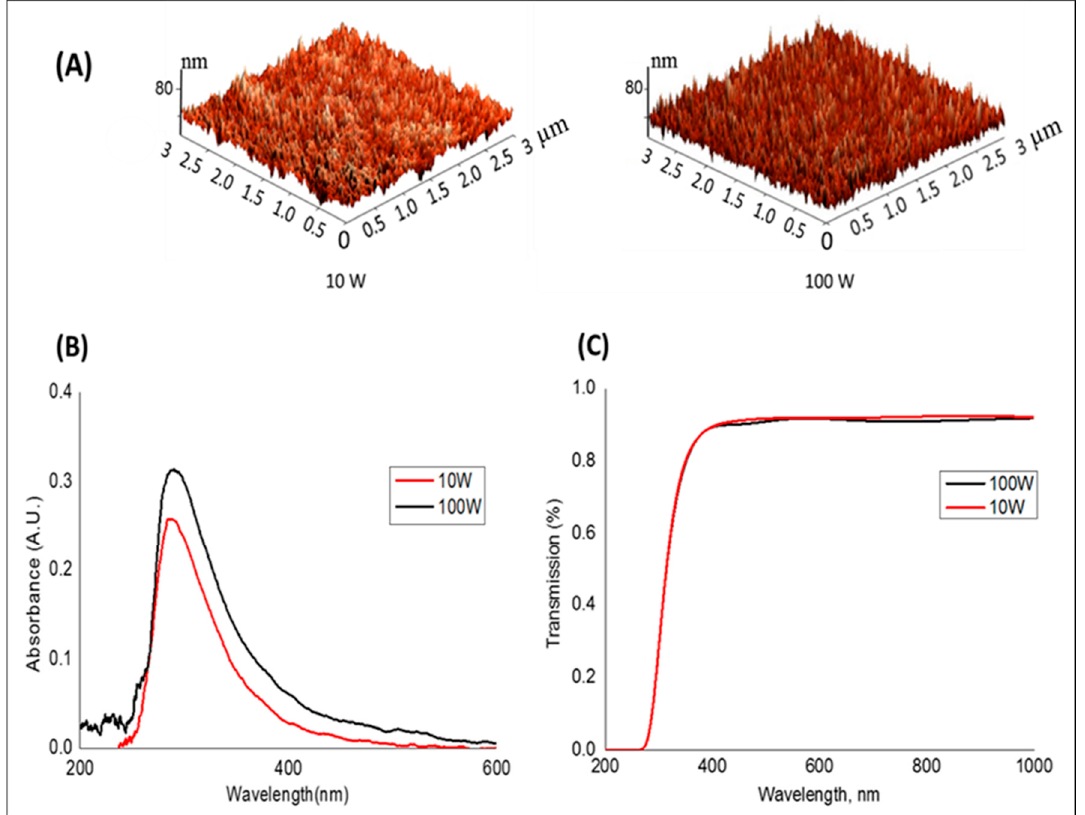
Figure 3. ( A ) Atomic force microscope images of pelargonium plasma polymer films fabricated at 10 W and 100 W. ( B ) Ultraviolet–visible spectroscopy (UV-VIS) measurements of pelargonium plasma polymer films deposited at various input power. ( C ) Optical transmission of pelargonium plasma polymer films deposited at 10 W and 100 W.